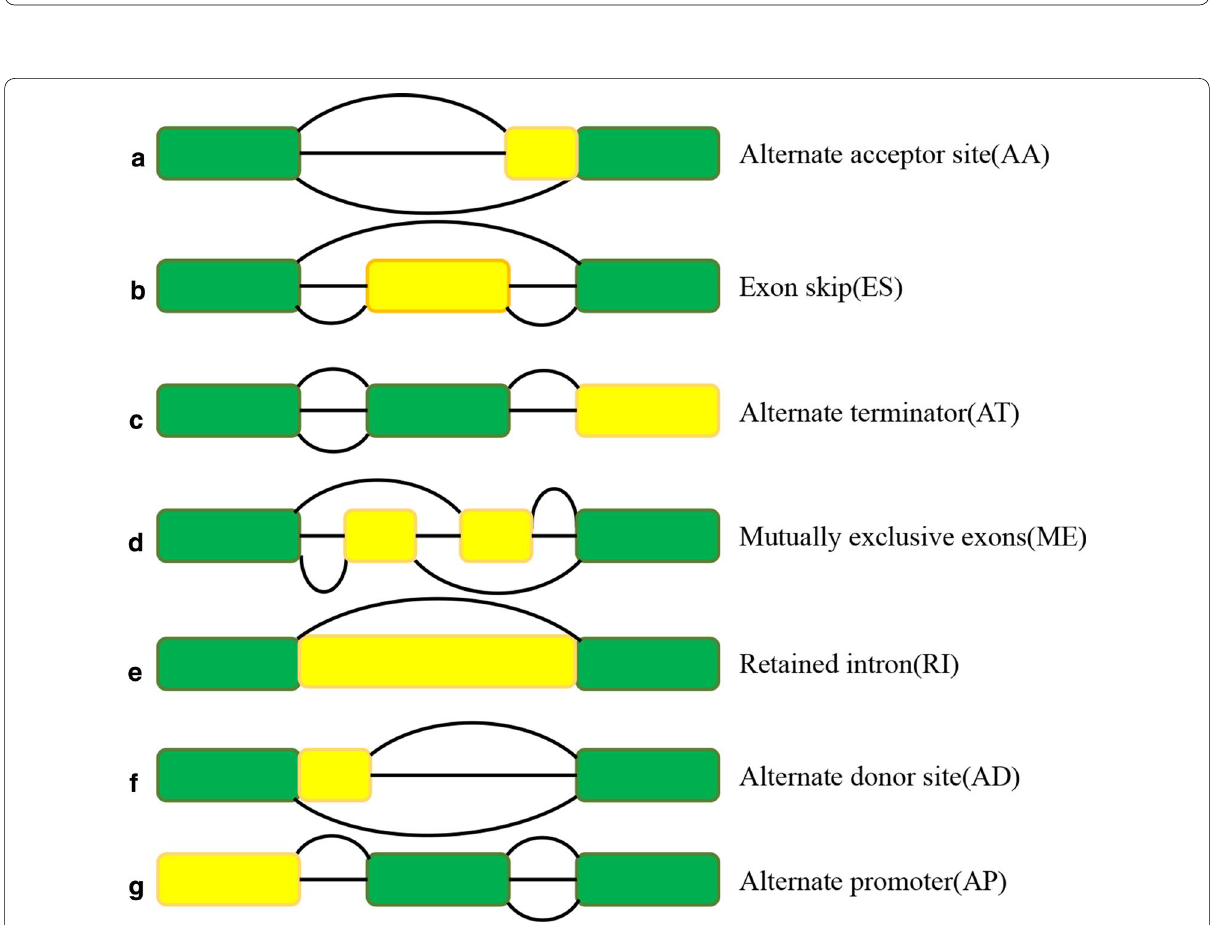
Fig. 3 A schematic showing the seven types of alternative splicing examined in this study. a Alternate acceptor site, AA; b exon skip, ES; c alternate terminator, AT; d mutually exclusive exons, e ME; retained intron, RI; f alternate donor site, AD; g alternate promoter,